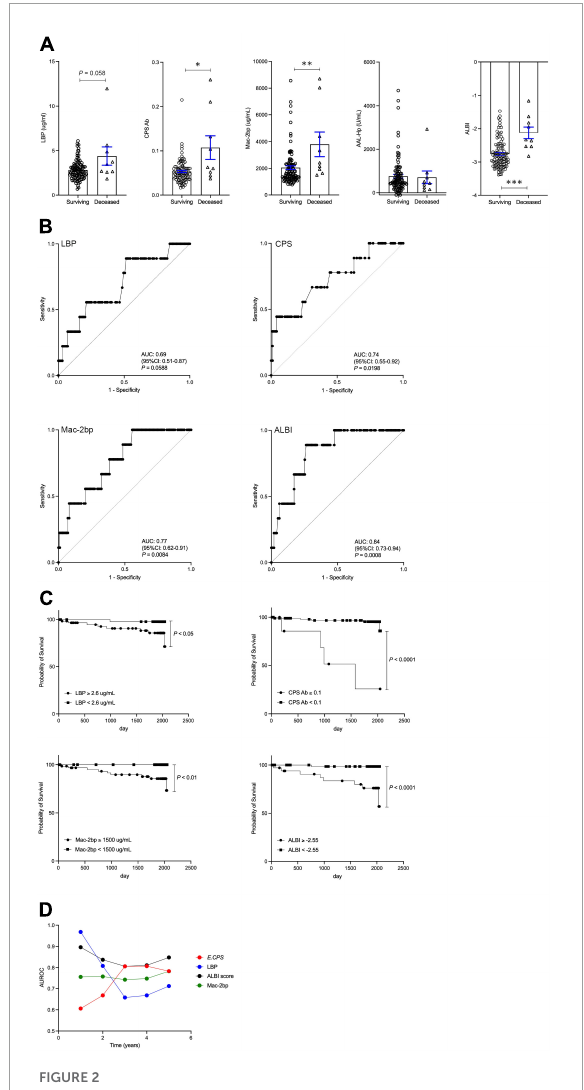
FIGURE2 The contributions of LBP, E. CPS, Mac-2 bp, AAL-Hp and ALBI score to overall survival. (A) Surviving vs. deceased, (B) receiver operator characteristic analysis of survival curves, (C) survival curves, (D) Plots of 1 year AUROC for LBP, E. CPS, Mac-2 bp and ALBI score. LBP, lipopolysaccharide-binding protein; E. CPS, E. faecalis capsular polysaccharide; Mac-2 bp, Mac-2 binding protein; AAL-Hp, Aleuria aurantia lectin-haptoglobin; ALBI, albumin-bilirubin; AUROC, area under the receiver operator characteristic curve; CI, confidence interval. ∗ p < 0.05, ∗∗ p < 0.01, ∗∗∗ p < 0.001.